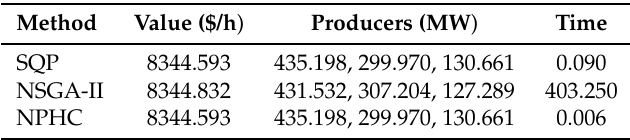
Table 4. Minimization of fuel cost.